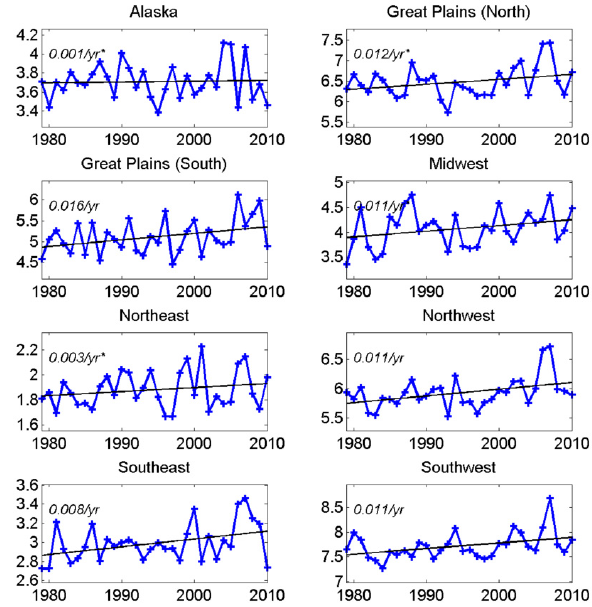
Fig. 11. Fire season PE ( + ) for each NCA region between 1980 and 2010. Values indicate the linear trends in fire season PE (black lines) during this period. Starred values indicate statistically significant PE trends based on robust linear regression ( p <